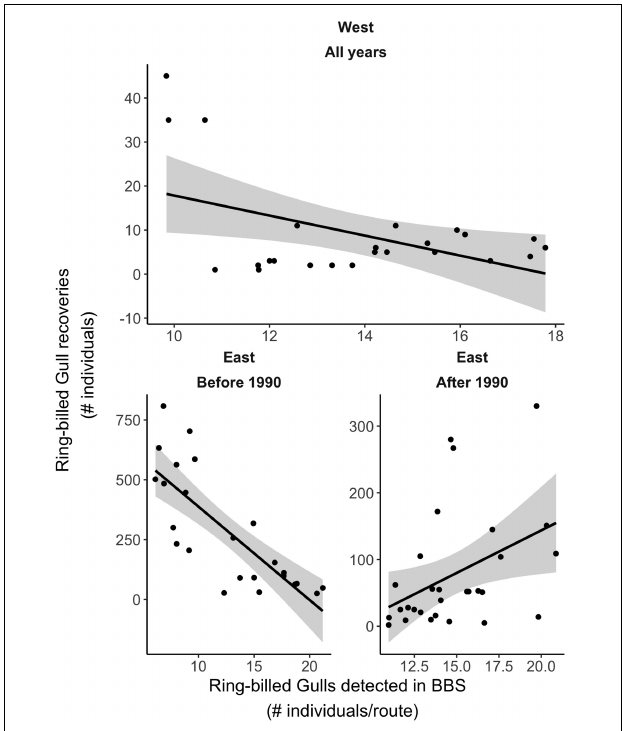
FIGURE 7 | The association between Ring-billed Gull population size and band recoveries was significantly negative in the West region (top). Declines and increases in bird recoveries with increasing size (Eastern birds, pre- and post-1990, respectively) (bottom), no relationship between recoveries and size evident for East Central and West Central regions (not